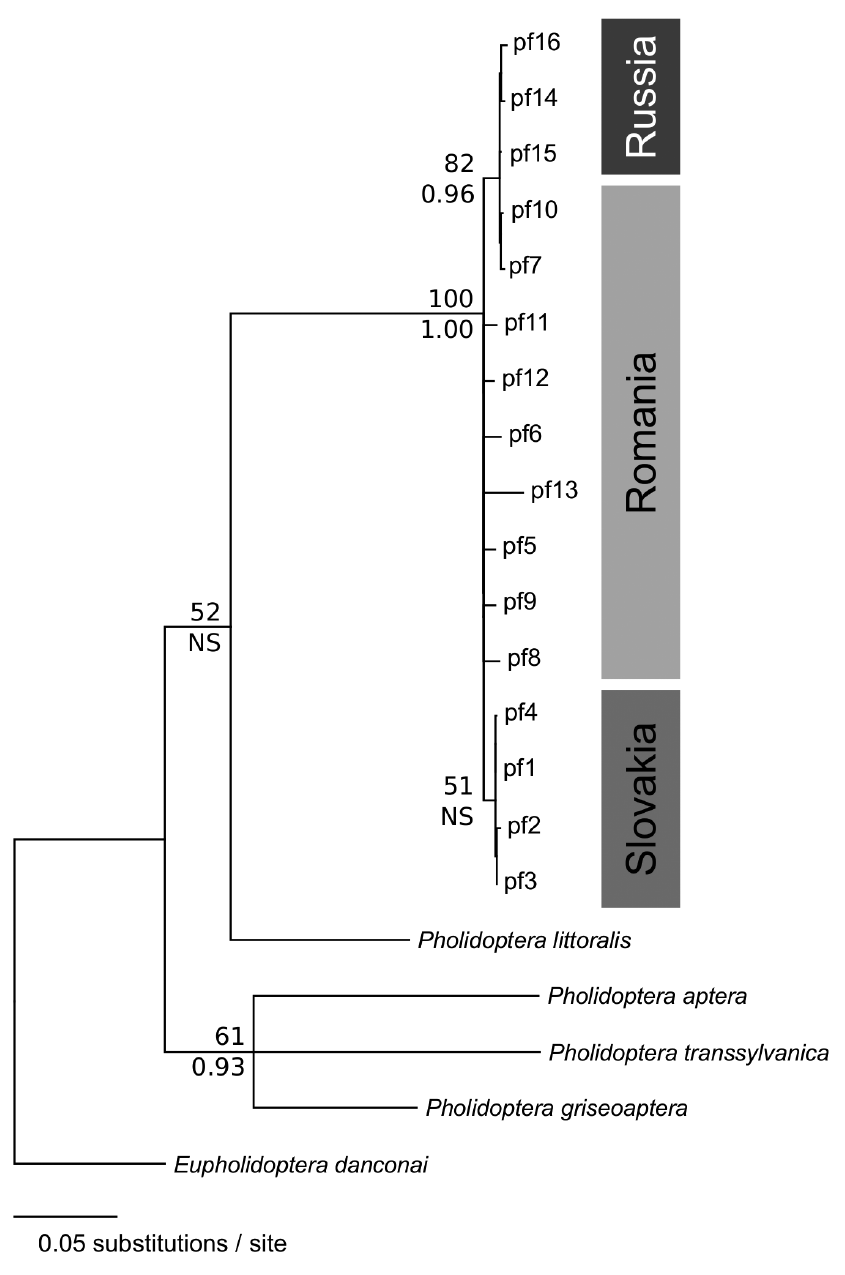
Figure 2. Maximum-likelihood (ML) phylogenetic tree for 16 haplotypes of Pholidoptera frivaldszkyi (pf1–pf16; GenBank accession numbers KF706416–KF706428, KY554960–KY554962) with outgroup species (KC852400, KY554963–KY554966) based on a 778 bp fragment of the mtDNA COI gene. Tree topology and branch lengths of Bayesian inference were congruent with ML analysis. Nodes with significant support values are indicated (upper, ML bootstrap > 50%; lower, Bayesian posterior probability >